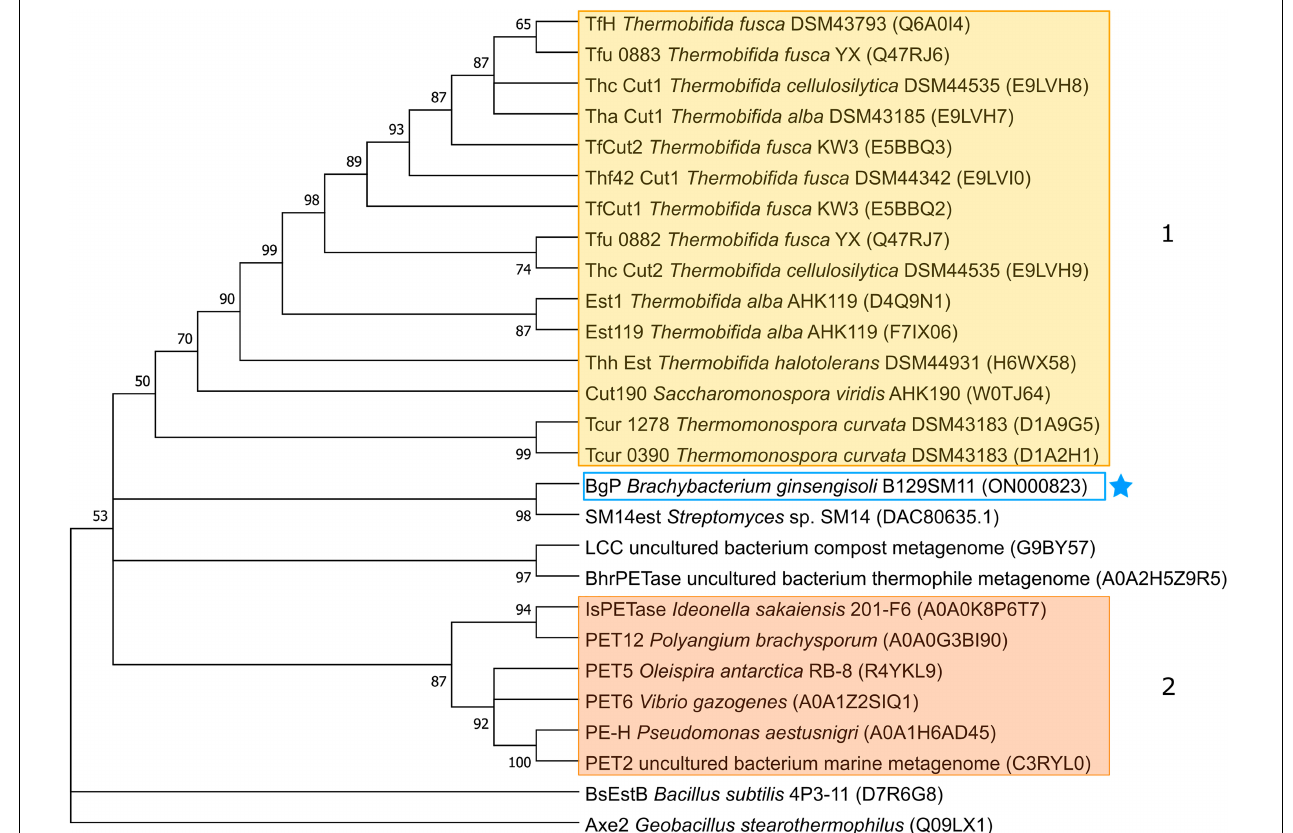
FIGURE 1 | Maximum-likelihood (ML) phylogenetic tree of BgP among known PET-hydrolyzing enzymes and homologs from the reference dataset. Bootstrap consensus was inferred with 100 replicates, displaying only values above 50%, and the best-fit substitution model for this tree was WAG + G. Two main taxonomic clades are indicated; (1) proteins from thermophilic Actinobacteria (shaded in yellow) and (2) proteins from psychrophilic or mesophilic Proteobacteria (shaded in orange). BgP (starred) is tightly clustered with marine sponge-derived SM14est. LCC and BhrPETase from metagenomic thermophiles are also clustered together. A Geobacillus stearothermophilus acetylxylan esterase, Axe2 (UniProt Accession Number: Q09LX1) served as an outgroup.